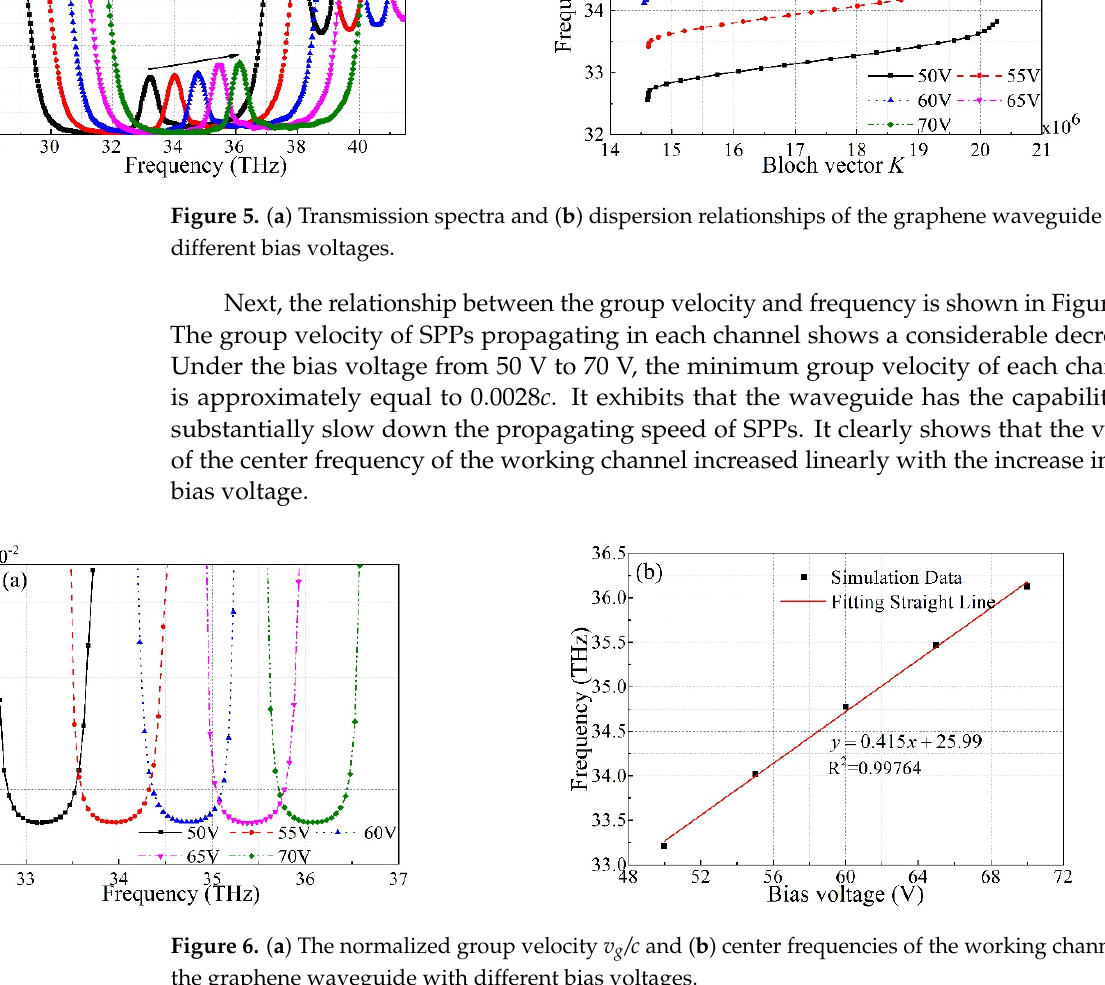
Figure 4. ( a ) Dispersion relationship of the graphene waveguide with bias voltage 60 V. ( b ) The normalized group velocity v g /c of SPPs propagating on interface of graphene waveguide with bias voltage 60 V.